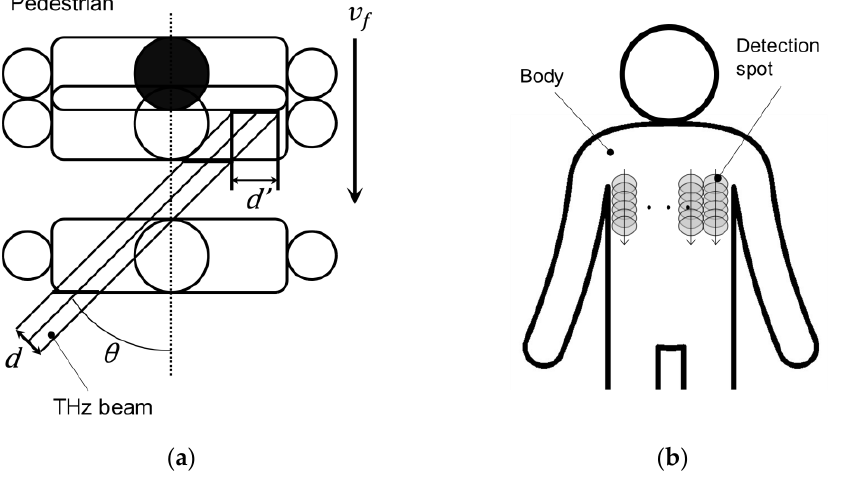
Figure 2. ( a ) Conceptual view of the measurement from above. ( b ) A conceptual view of the pedestrian from the front.